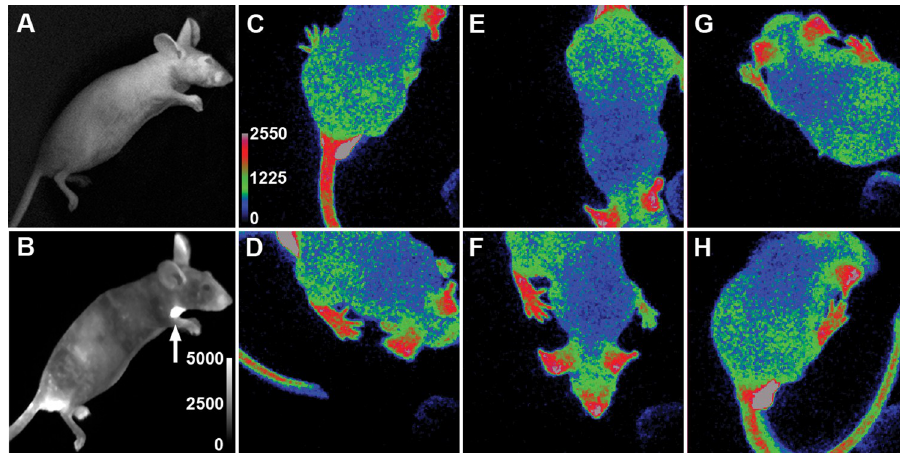
Fig 1. Freely moving mice and unconscious mice imaged after intraperitoneal luciferin injection. A: Brightfield image of an immobile (anesthetized) male Hr-Per1 mouse. B: Corresponding bioluminescence alone after 10-min image capture of the same mouse injected with luciferin showing high expression in several body areas including the submandibular gland (arrow) and testes. C-H: Bioluminescence in a freely moving male mouse after luciferin injection. Frames were selected to show various body postures captured during a 1-min sequence of 0.5 second images collected with 100x EM gain and 2 x 2-pixel binning. The entire body is visible and shows high gene expression in paws, ears, snout, and tail. Signal in the testes ( C & H ) is higher than the intensity range shown by the scale. The intensity ranges shown are in analog-to-digital units (ADUs) of the CCD